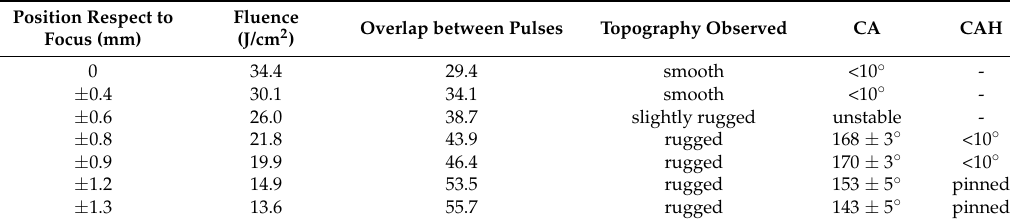
Table 1. The CA and CAH measured on some of the structures created with the green